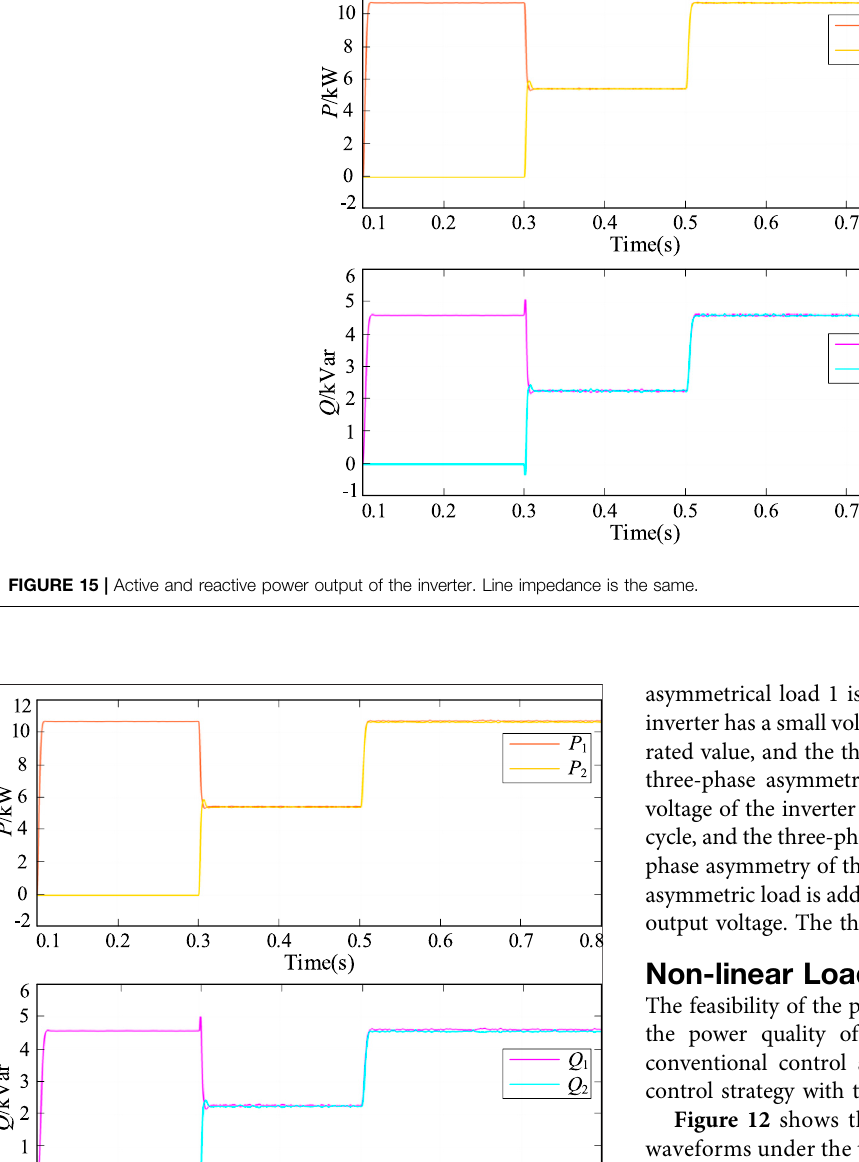
Frontiers in Energy Research |